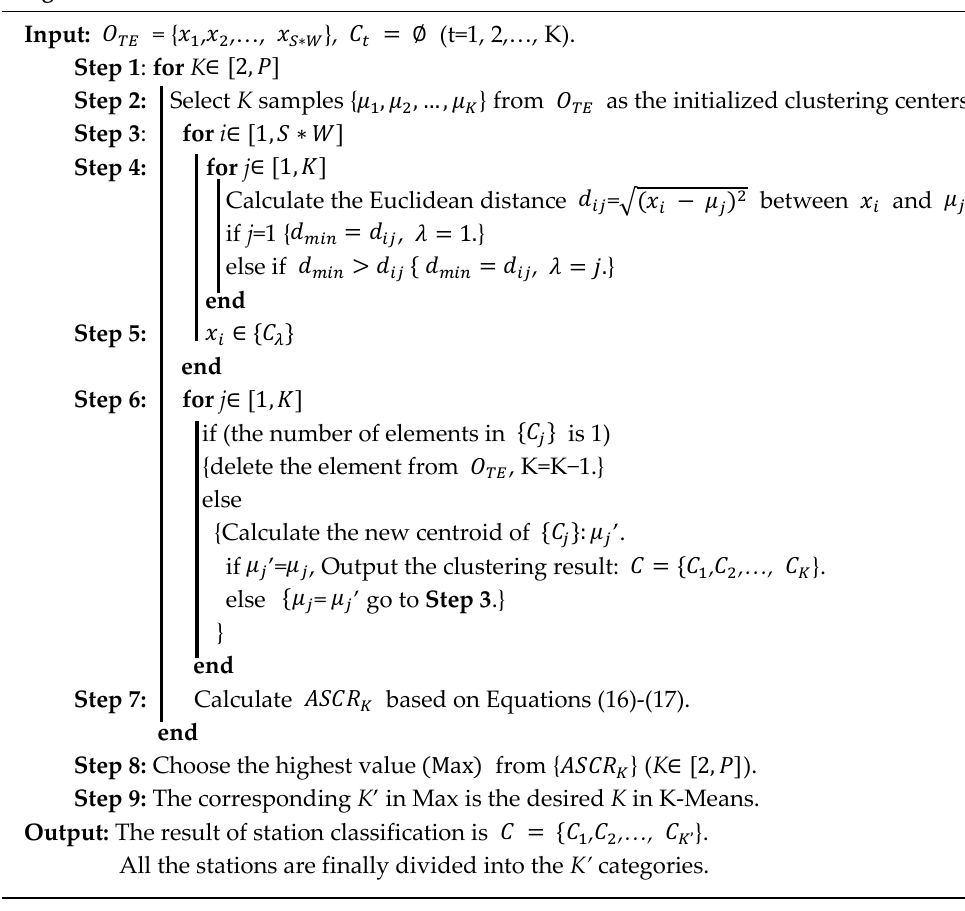
Algorithm 1: K-Means for station classification .